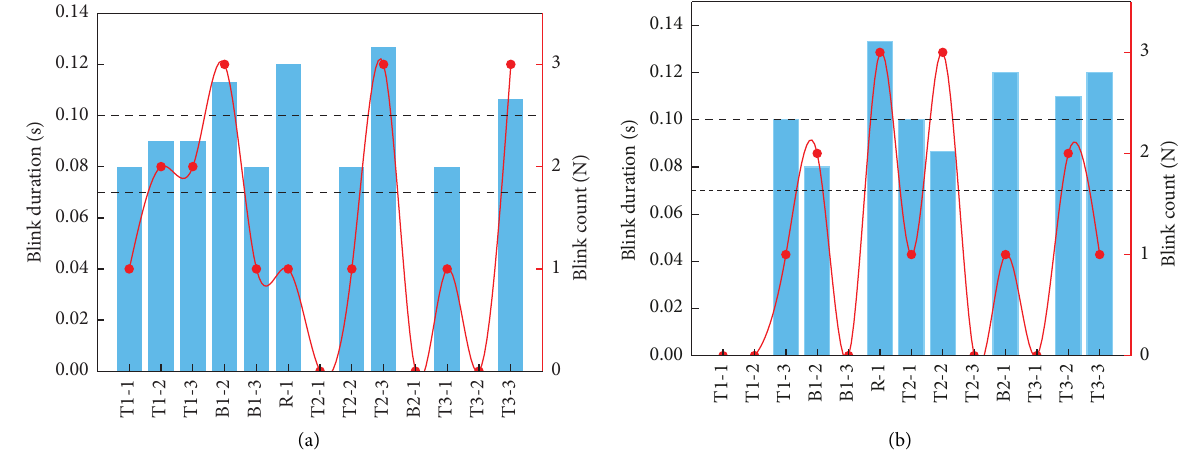
Figure 7: Blink behavior. (a) Day. (b)